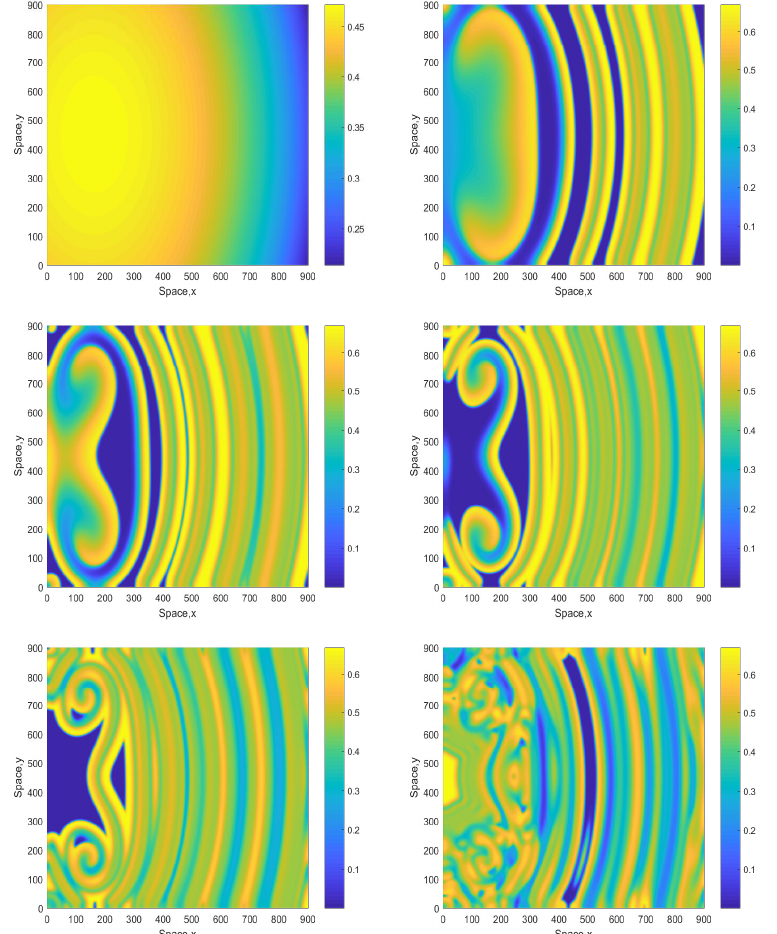
Figure 8. Spatial distribution of the oxygen concentration obtained for A = 2.07 and shown for t = 1, t = 180, t = 220, t = 250, t = 290 and t = 500 (left to right, top to bottom). Other parameters and the initial conditions are the same as in Figure 7.